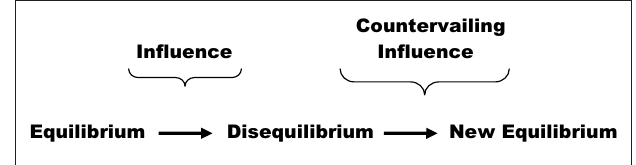
Figure 1 | Classical Le Chatelier–Braun schema.